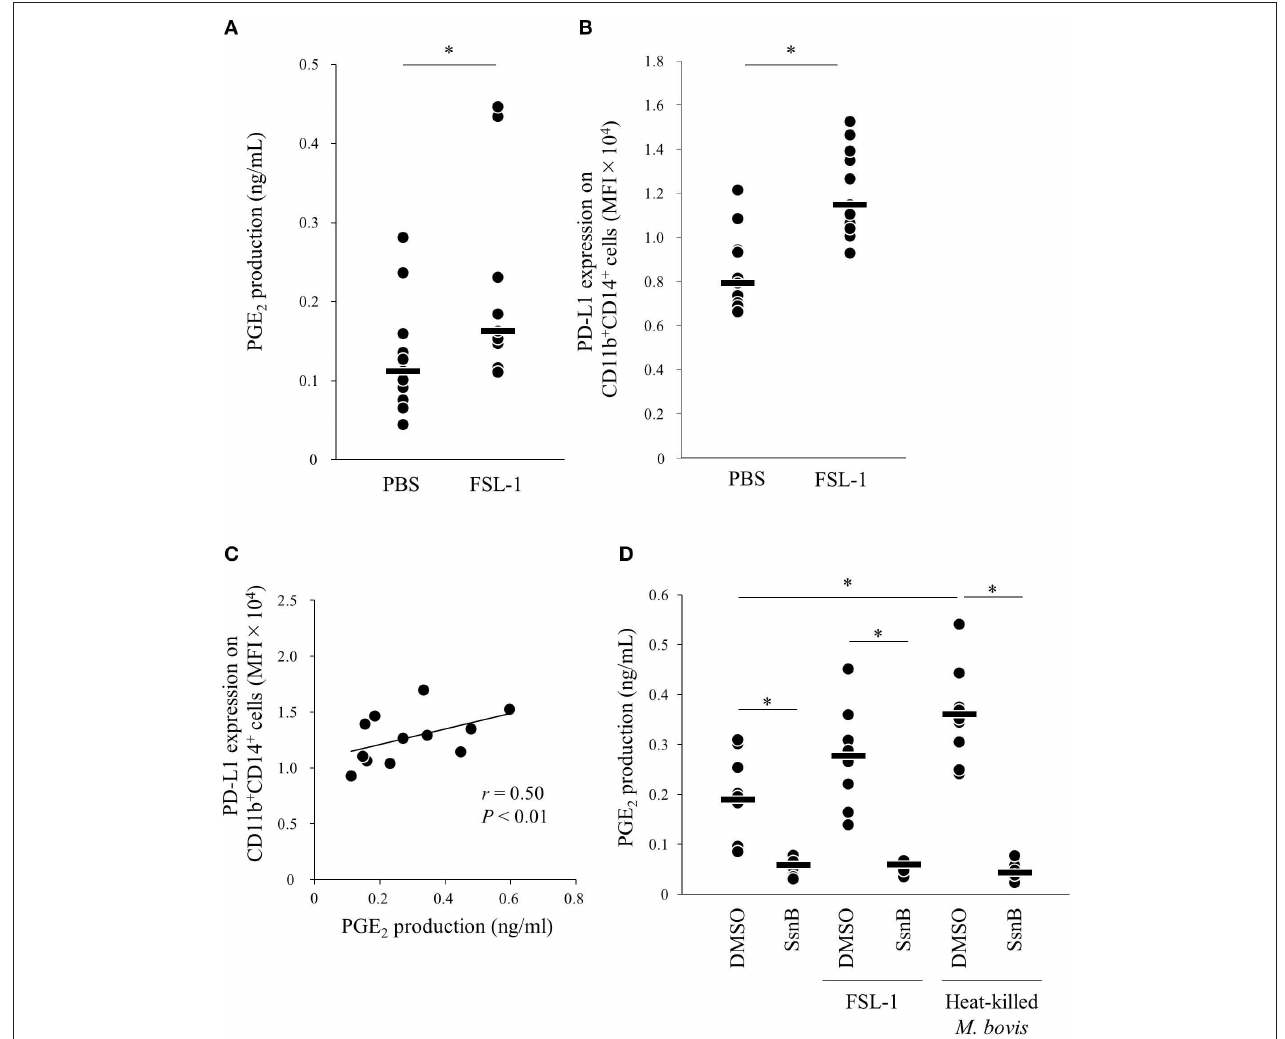
FIGURE 3 | TLR2 signaling upregulates PD-L1 and PGE 2 expression. PBMCs from uninfected cattle were incubated with FSL-1 (100ng/ml). (A) PGE 2 production was determined by ELISA (PBS: n = 11, FSL-1: n = 11). (B) PD-L1 expression on CD14 + cells (PBS: n = 11, FSL-1: n = 11) was determined by flow cytometry. (C) Positive correlation is noted between PD-L1 expression on CD11b + CD14 + monocytes and PGE 2 levels under FSL-1 stimulation ( n = 13). (D) PBMCs from uninfected cattle were incubated with FSL-1 (100ng/ml) or heat-killed M. bovis (1.5ng/ml) under inhibition of TLR signaling by SsnB and PGE 2 production was determined by ELISA (DMSO: n = 9, SsnB: n = 9, DMSO and FSL-1: n = 9, SsnB and FSL-1: n = 9, DMSO and M. bovis : n = 9, SsnB and M. bovis : n = 9). The bars are the median of the values (A,B,D) . Statistical significance was determined by the Mann–Whitney U -test (A,B) or the Steel–Dwass test (D) . Correlation statistics were analyzed using Spearman’s correlation analysis (C) . * P <